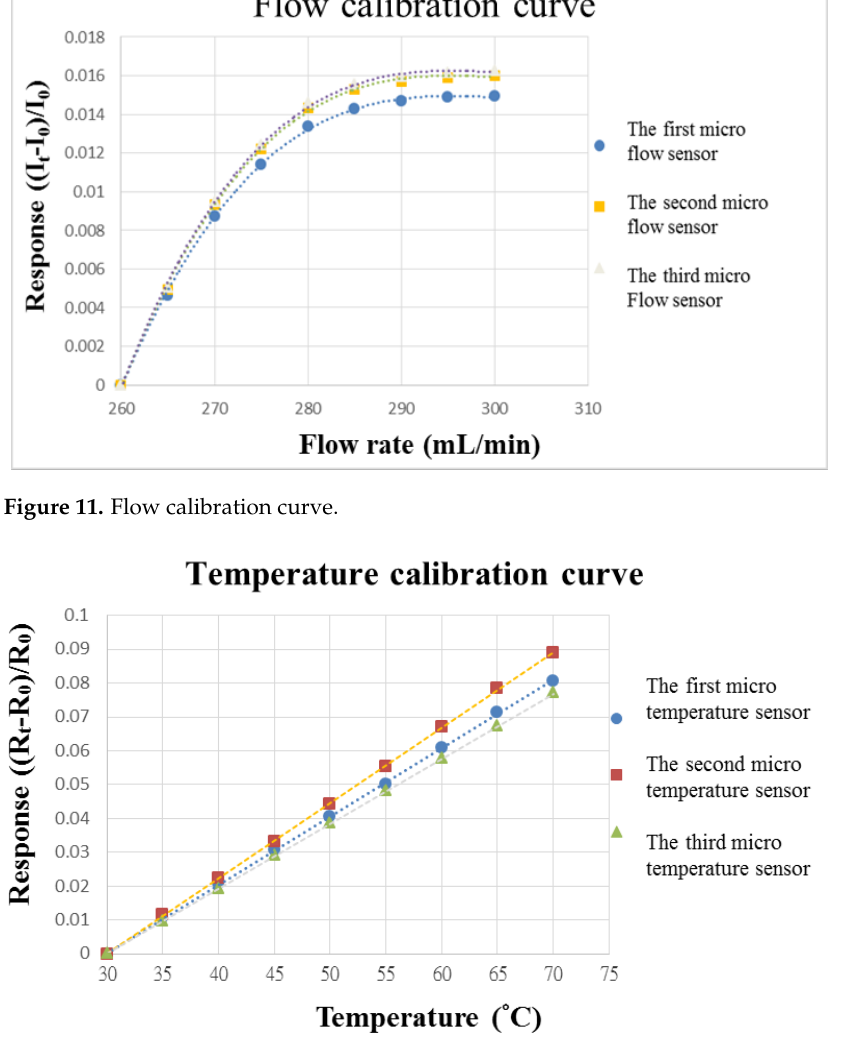
Figure 12. Temperature calibration curve.